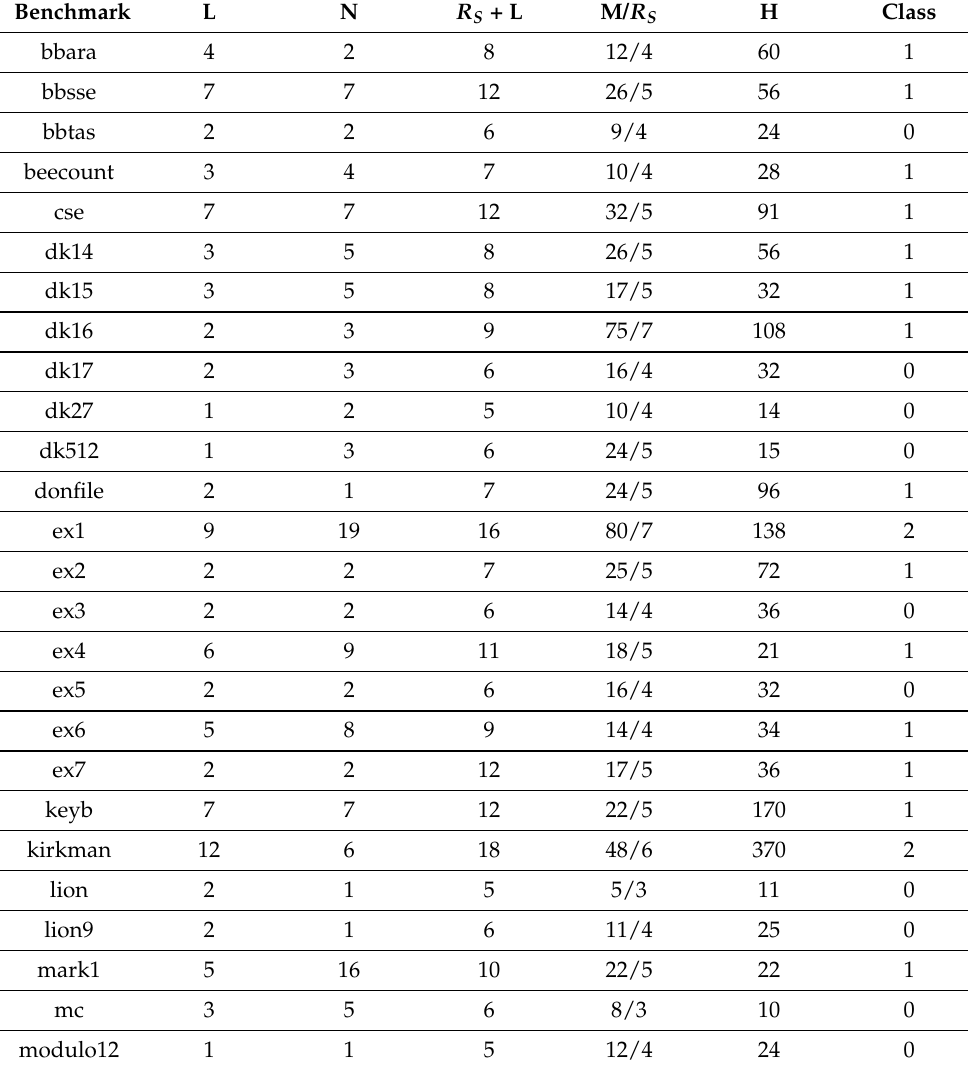
Table 6. Characteristics of Mealy FSM